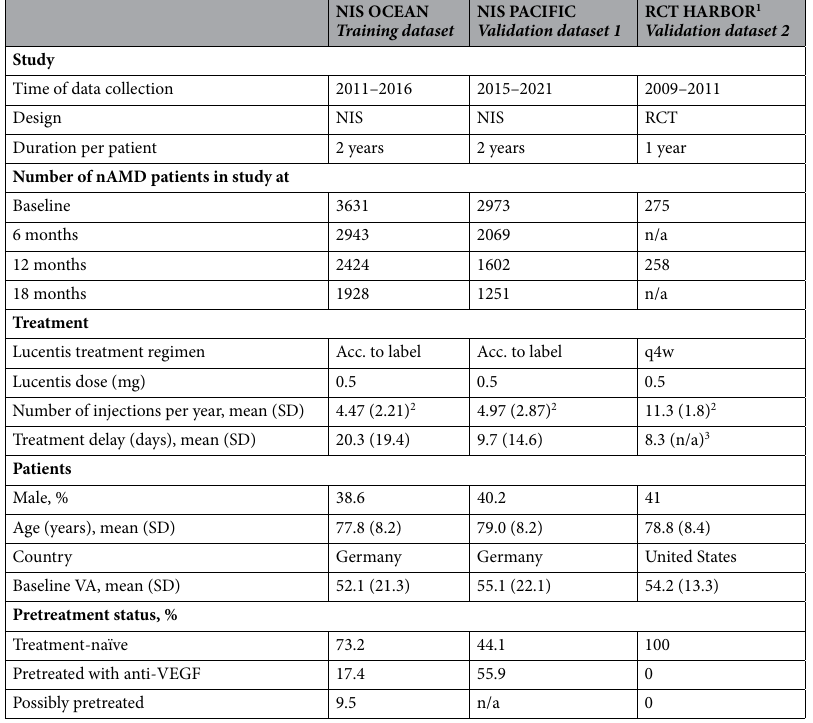
Table 1. Summary of studies used for model training (NIS OCEAN) and validation (NIS PACIFIC, RCT HARBOR). nAMD neovascular age-related macular degeneration; NIS non-interventional study; RCT randomized controlled trial; SD standard deviation; VA visual acuity; VEGF Vascular Endothelial Growth Factor. 1 Only HARBOR patients of the ranibizumab 0.5 mg q4w arm if not indicated otherwise. 2 1st year. 3 All HARBOR patients (n =